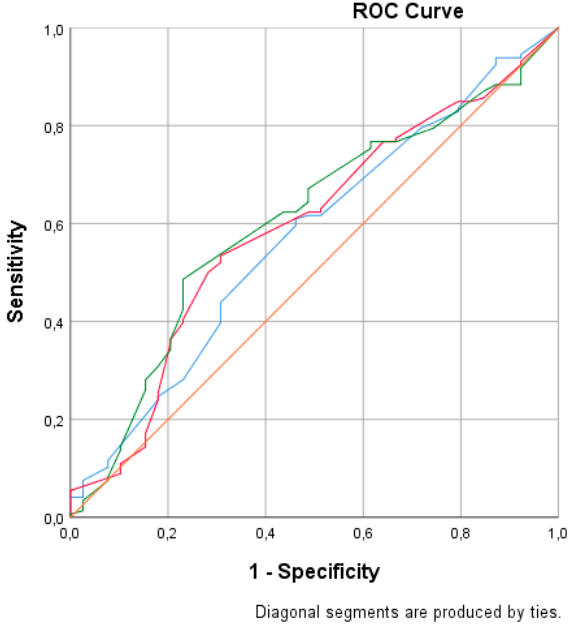
Figure 1. The trend of wages requirement according to the work-time.